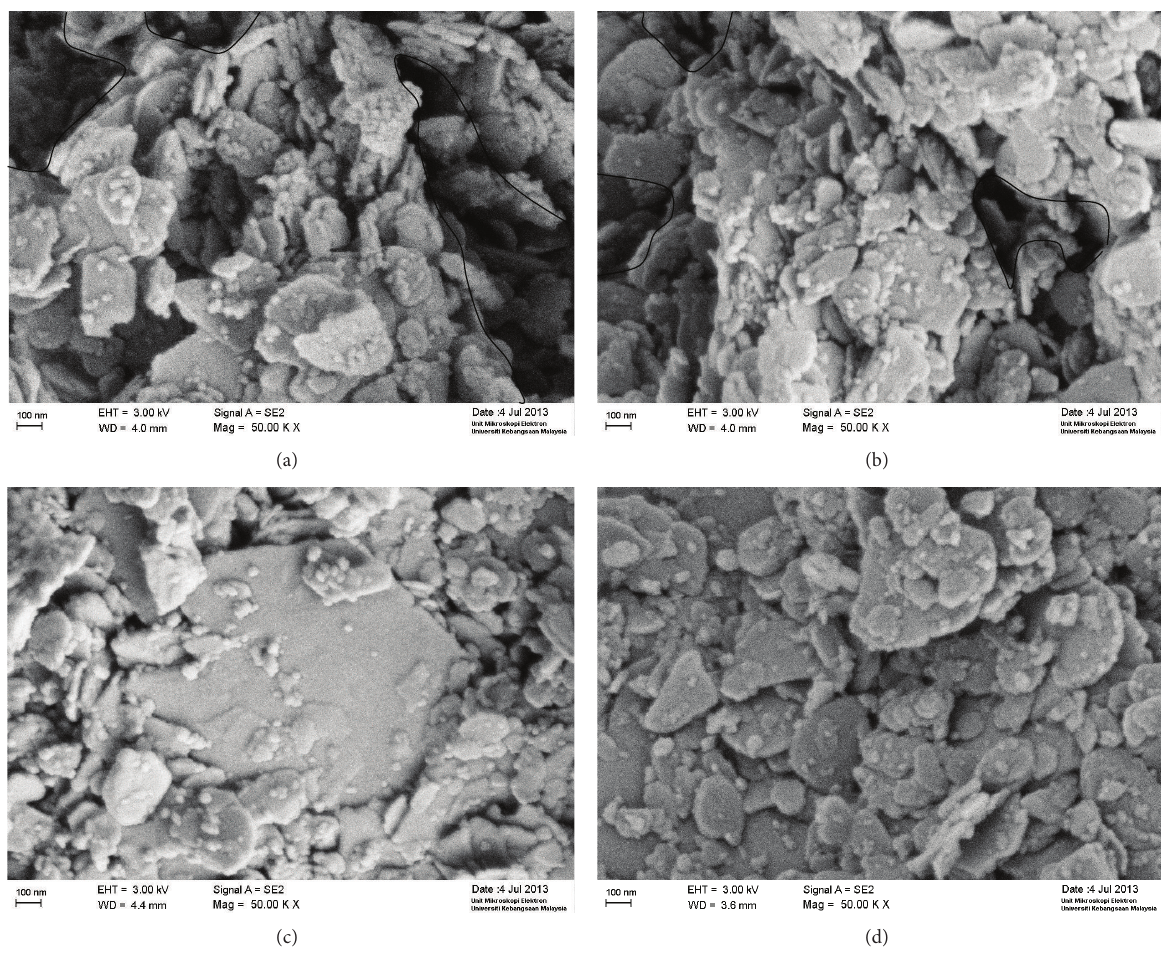
Figure 8: FESEM results: (a) UT, (b) E-I-D2, (c) E-II-D2, and (d)